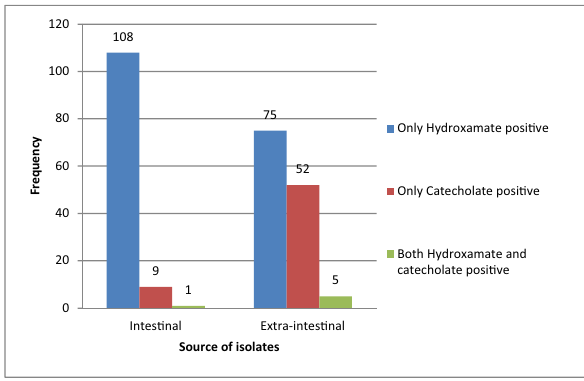
Figure 2: Frequency of siderophore types among pathogenic E. coli